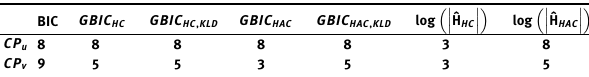
Fig. 5. Side view from the west of the historic masonry arch bridge under study. The challenge of data preprocessing was to eliminate unwanted objects from the point clouds (image from (Paffenholz, Huge and Stenz 2018)) Table 2. Optimal number of CP in the u and v directions for all crite- ria. Additionally, the minimum or inflexion point of the logdet term is given in the two last